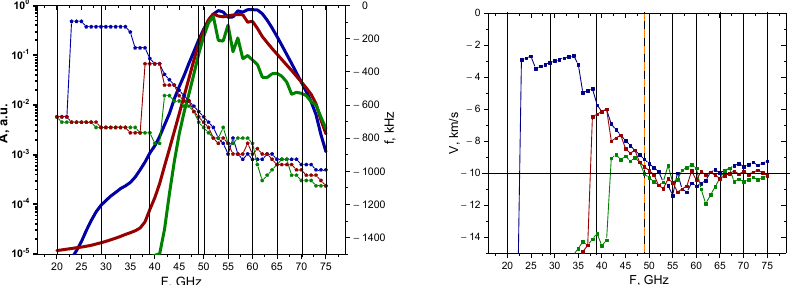
Figure 31. For the poloidally stretched filament with an amplitude of 0.1%: ( left ) dependency of the DBS signal amplitude (bold lines with scale on the left) and frequency (lines with pentagon shapes with scale on the right) on the probing frequency; ( right ) dependency of the calculated velocity on the probing frequency. The navy-blue lines are the circular filament with a 3 cm diameter, the wine- red are that of 1.5 cm, and the olive-green are that of 0.5 cm. The black vertical lines indicate the probing frequencies available in Globus-M2, and the vertical orange dashed line indicates the posi- tion of the filament at cutoff of the 48 GHz probing wave. The horizontal line marks the set 10 km/s filament velocity.